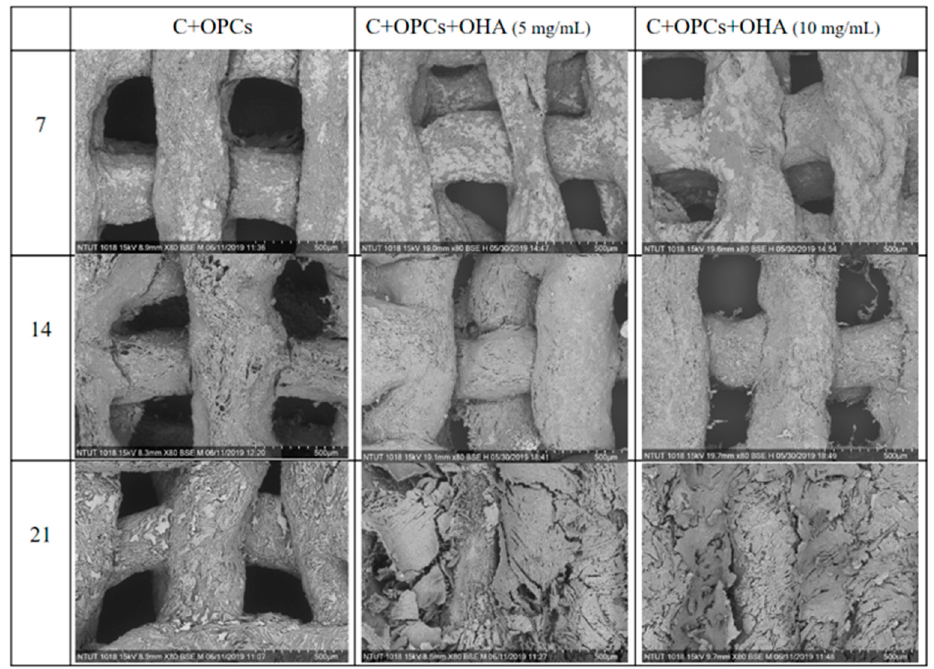
Figure 7. SEM images of collagen + OPC and collagen + OPC + OHA scaffolds after their immersion in simulated body fluid for 7, 14, and 21 days (magnification 80×).